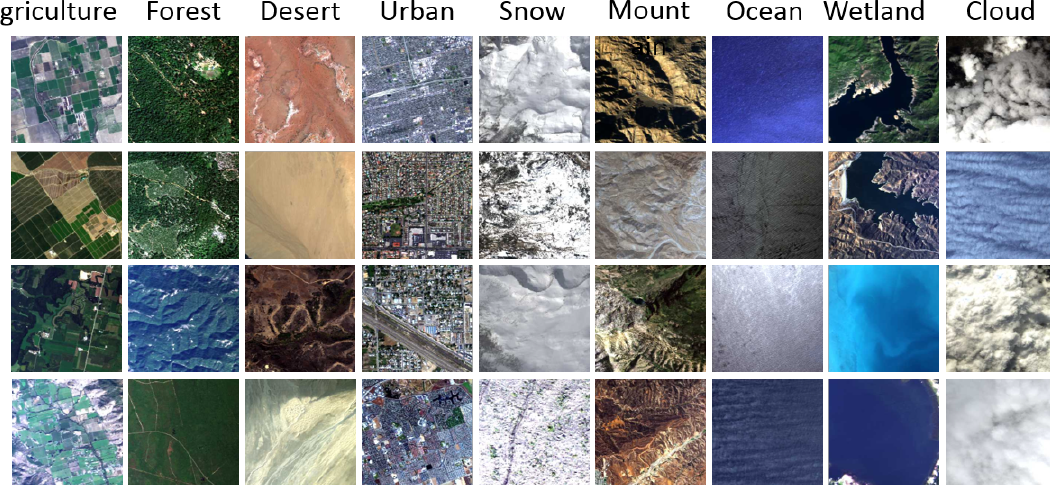
Figure 2. Examples from the ICONES-Hyperspectral Satellite Imaging dataset